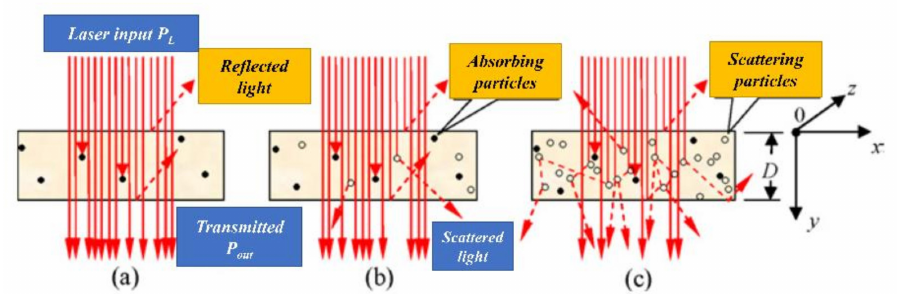
Figure 7. Schematic view of the laser beam transmission process in ( a ) light-absorbing non-scattering polymer; ( b ) light-absorbing single-scattering polymer; and ( c ) light-absorbing multi-scattering polymer [102]. Reproduced with permission from Ref. [102]. Copyright (2011), Journal of Materials Processing